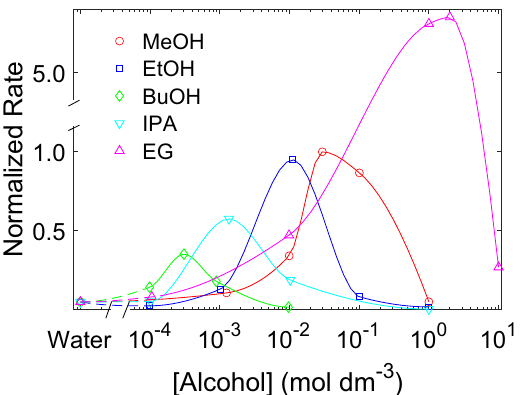
Figure 3. Rate of Ag-nanoparticle formation as a function of alcohol concentration. Methanol (MeOH) ( (cid:31) ), ethanol (EtOH) ( (cid:31) ), 1-butanol (BuOH) ( ♦ ), 2-propanol (IPA) ( ▽ ), and ethylene glycol (EG) ( △ ) were used as radical scavengers. The rate of Ag-nanoparticle formation is normalized to the optimum for the methanol series. Solid and dotted lines are drawn with spline interpolation to guide the eye.